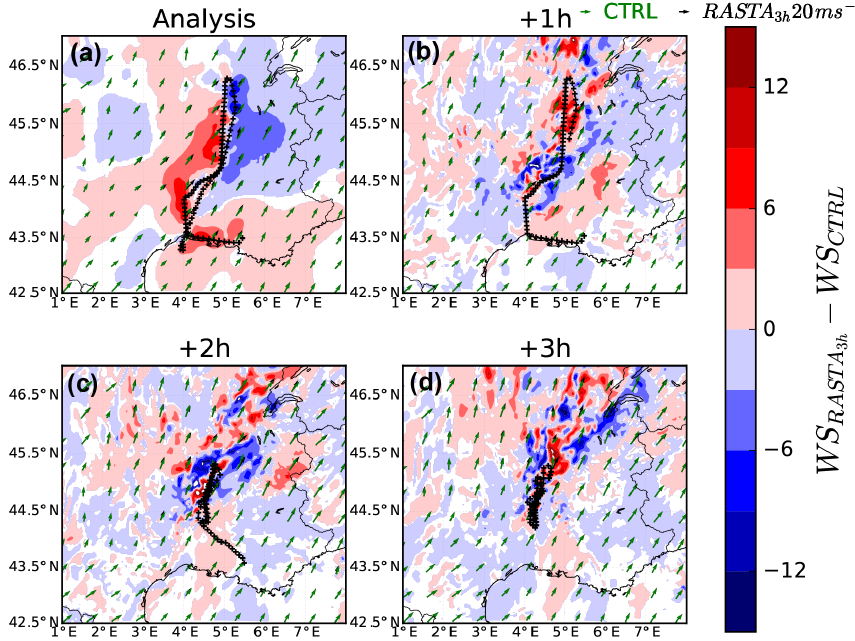
Figure 6. Wind increments between the RASTA IOP7 and the CTRL IOP7 experiments for the analysis at 06:00UTC and for the 1, 2 and 3h 3h forecasts at 07:00, 08:00 and 09:00UTC on 26 September 2012 (IOP7a) at approximately 4km of altitude (model level 30). The black data points represent the location of RASTA data within a 1h time window centred on the forecast term range.